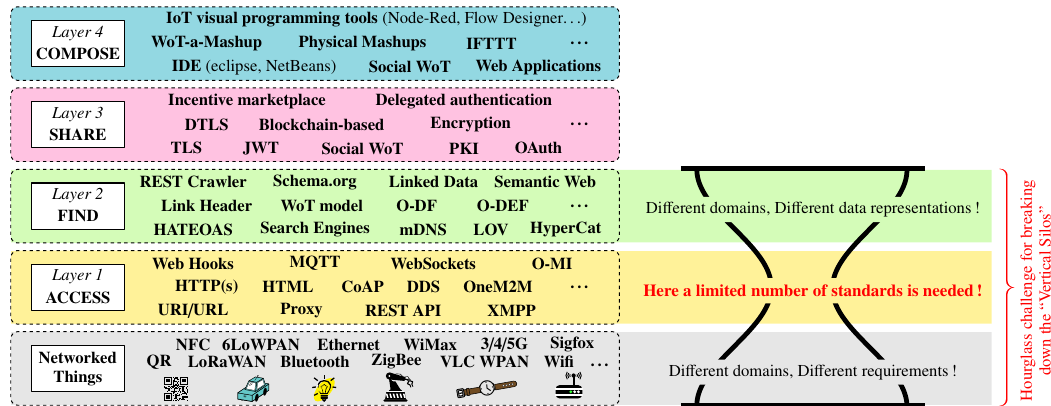
Figure 2. Key technological layers underlying open IoT ecosystems (adapted from